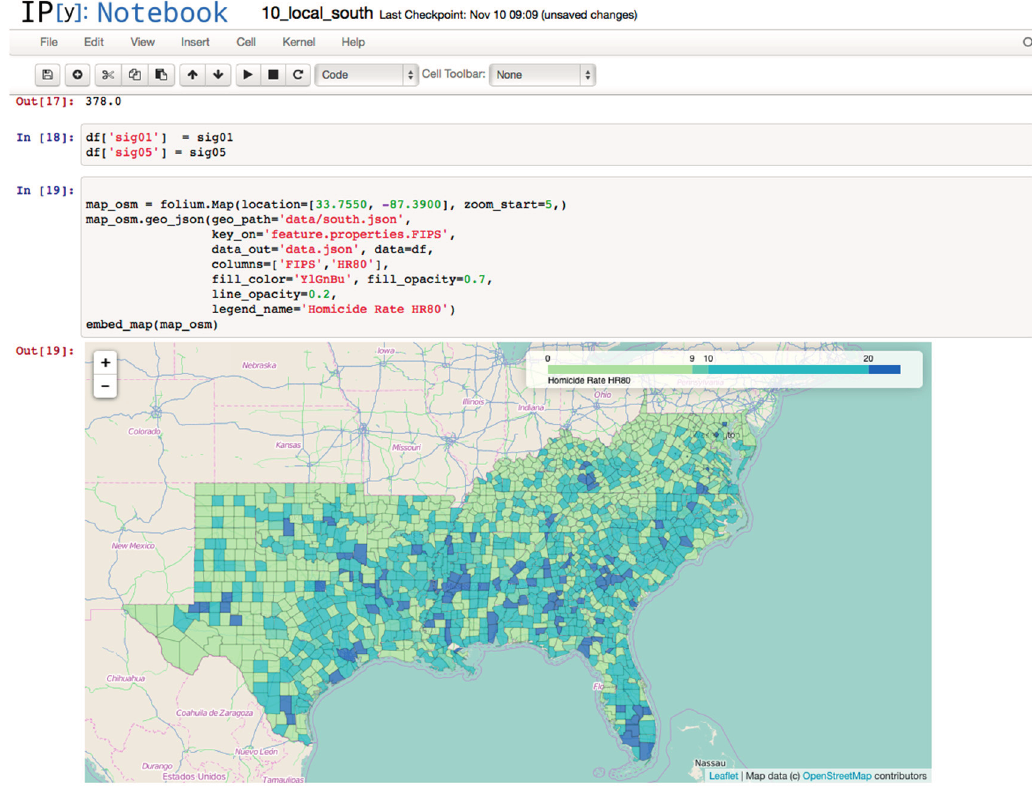
Figure 5. PySAL in the IPython